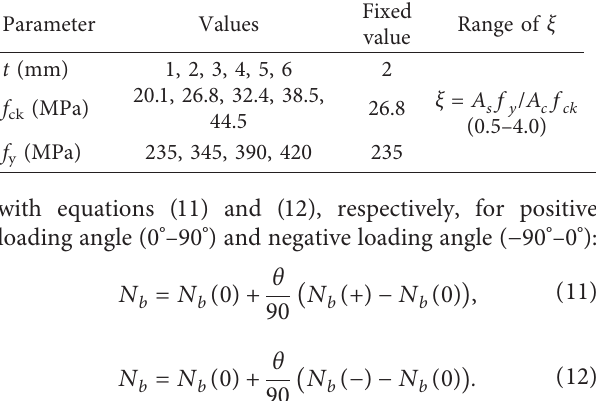
Figure 20: ( f ) sc /( f ) ck - ξ